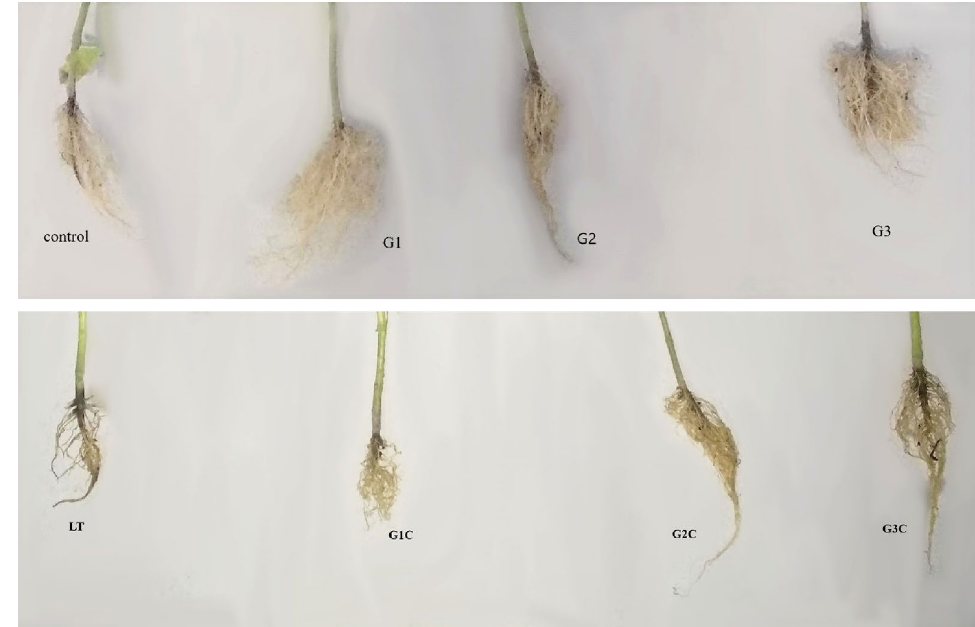
Figure 8. Changes pertaining to low temperature stress and different GSH concentration in root morphology. Control (Con): 25/18 °C + 0 mM GSH, Low temperature stress (LT): 10/3 °C + 0 mM GSH,